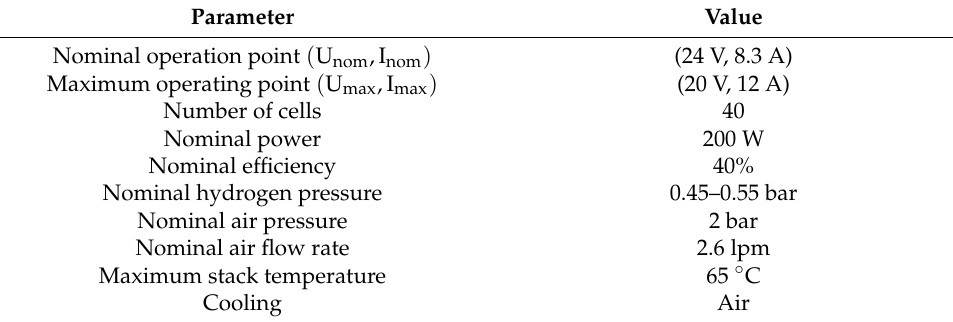
Table 8. PEMFC specifications.